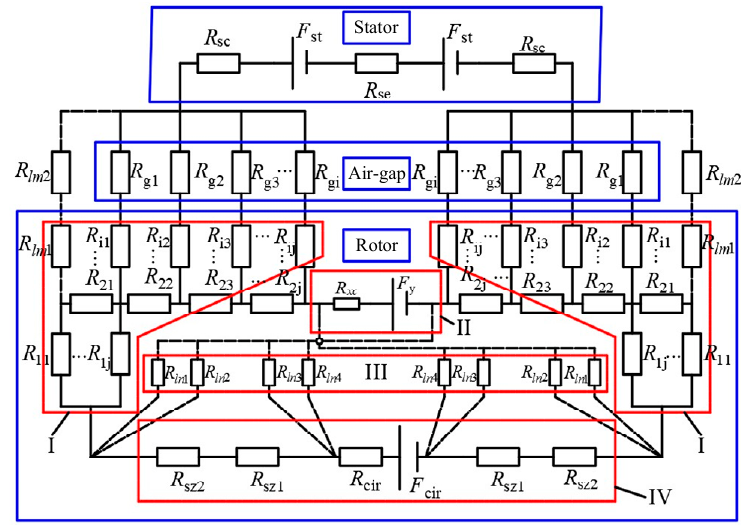
Figure 6. Improved equivalent magnetic network model.